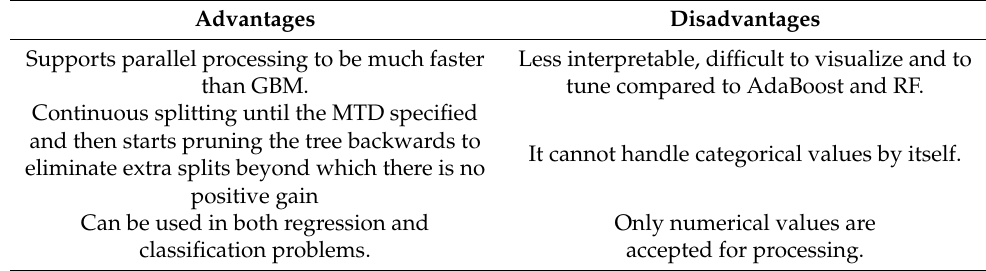
Table 5. Advantages and disadvantages of XGBoost.